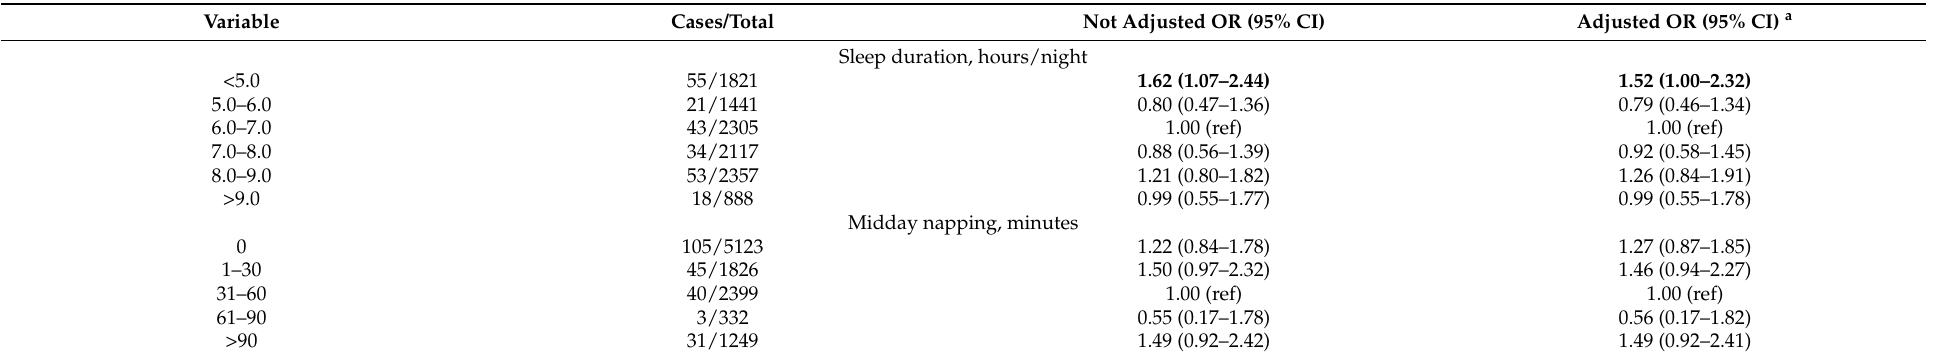
Table 2. Association of sleep duration and midday napping with hip